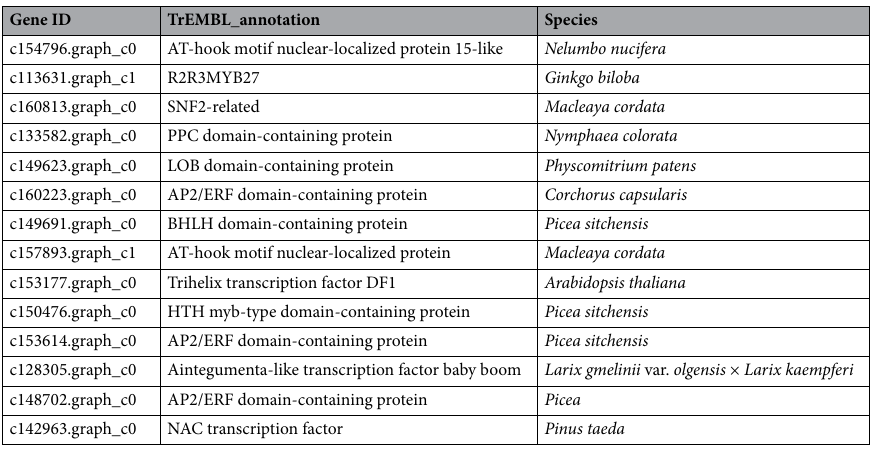
Table 3. Core genes